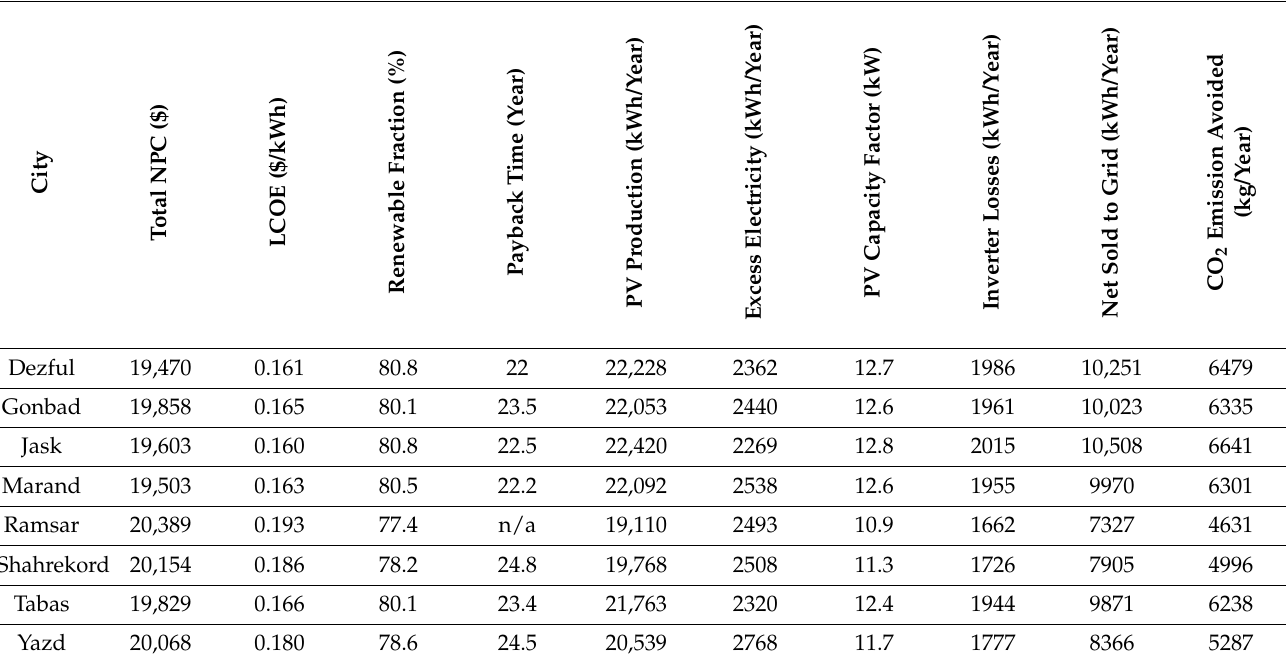
Table 15. The 90 ◦ slope decision-making